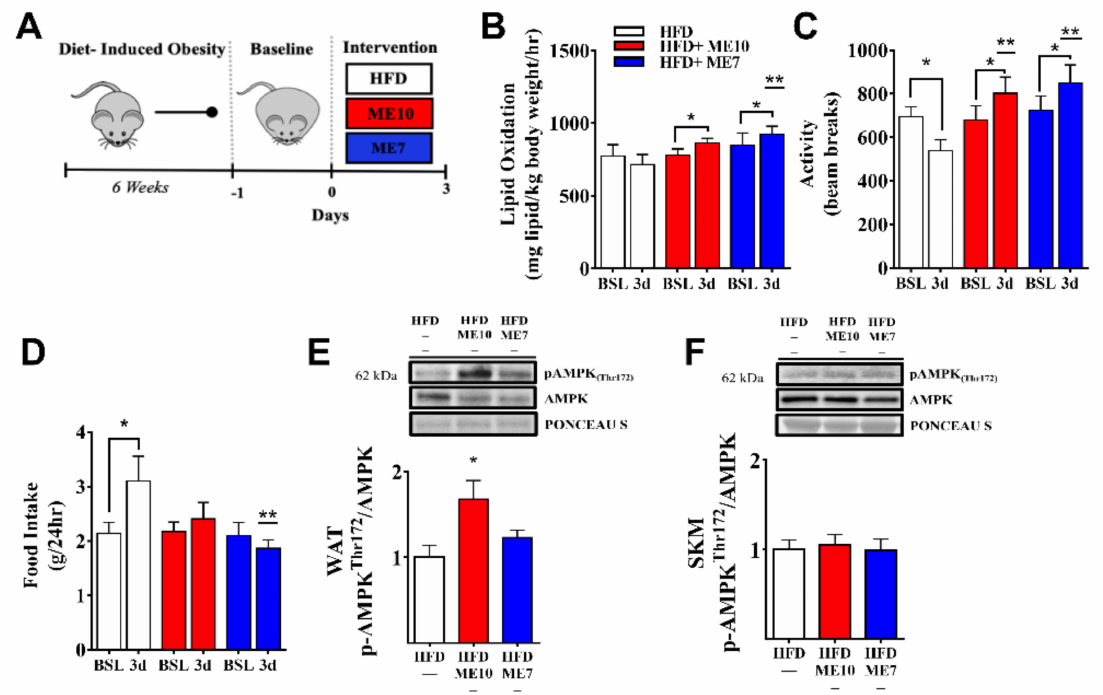
Figure 5. Short-term supplementation (3 days) of metabolic enhancer (ME) facilitates metabolic activity assessed via CLAMS. Experimental approach ( A ). Supplementation for a 3-day period (3d) increases lipid oxidation ( B ) and animal activity ( C ), and alters food intake compared to baseline (BSL) ( D ). *: p < 0.05 compared with BSL within groups, **: p < 0.05 compared to HFD following intervention (3d). Short-term supplementation increases AMPK phosphorylation (Thr172) in white adipose tissue (WAT) ( E ) but not skeletal muscle (SkM) ( F ). Representative blots of the total AMPK and p -AMPK Thr172 in adipose tissue (WAT) and skeletal muscle (SkM), respectively. *: p < 0.05 compared to the high-fat diet (HFD) group. Data are represented as the mean ± SEM ( n = 7–8 per